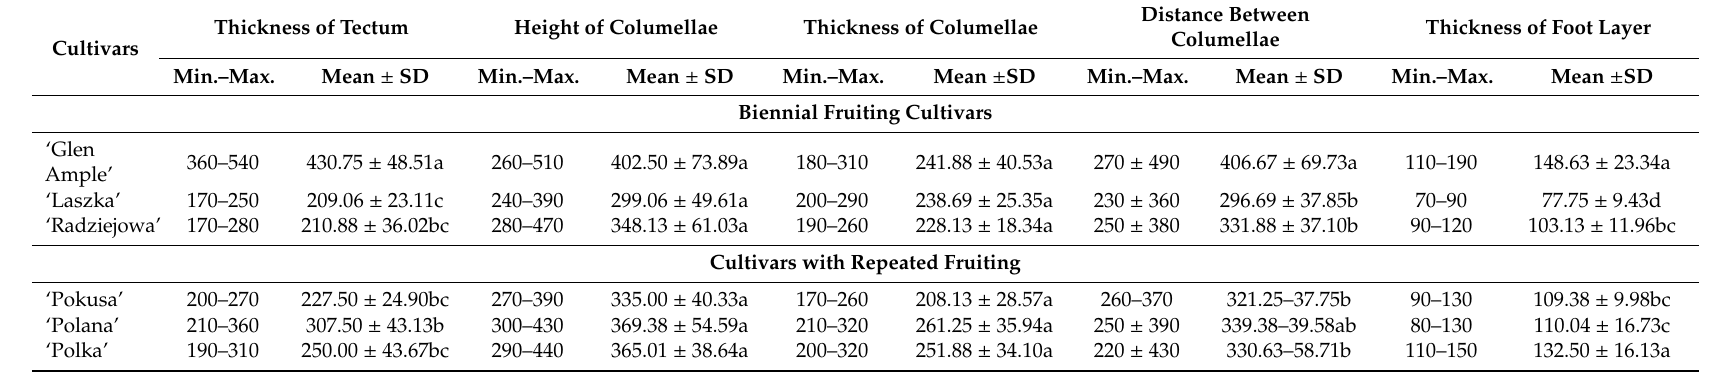
Table 4. Characteristics of selected traits of the ectoexine in the pollen grains of the examined R. idaeus cultivars (nm).